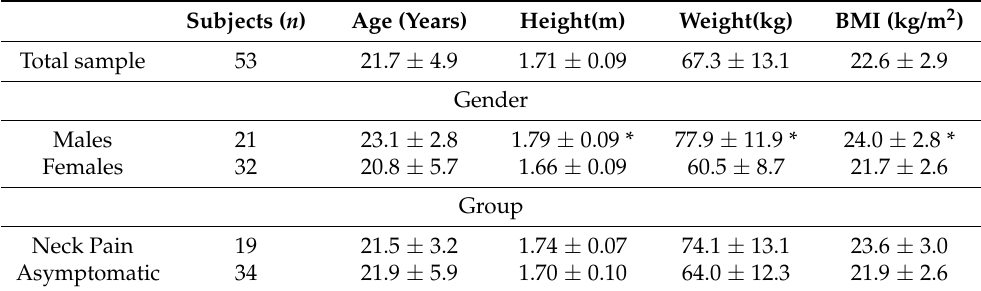
Table 1. Sociodemographic characteristics of the total sample, by gender, and group.